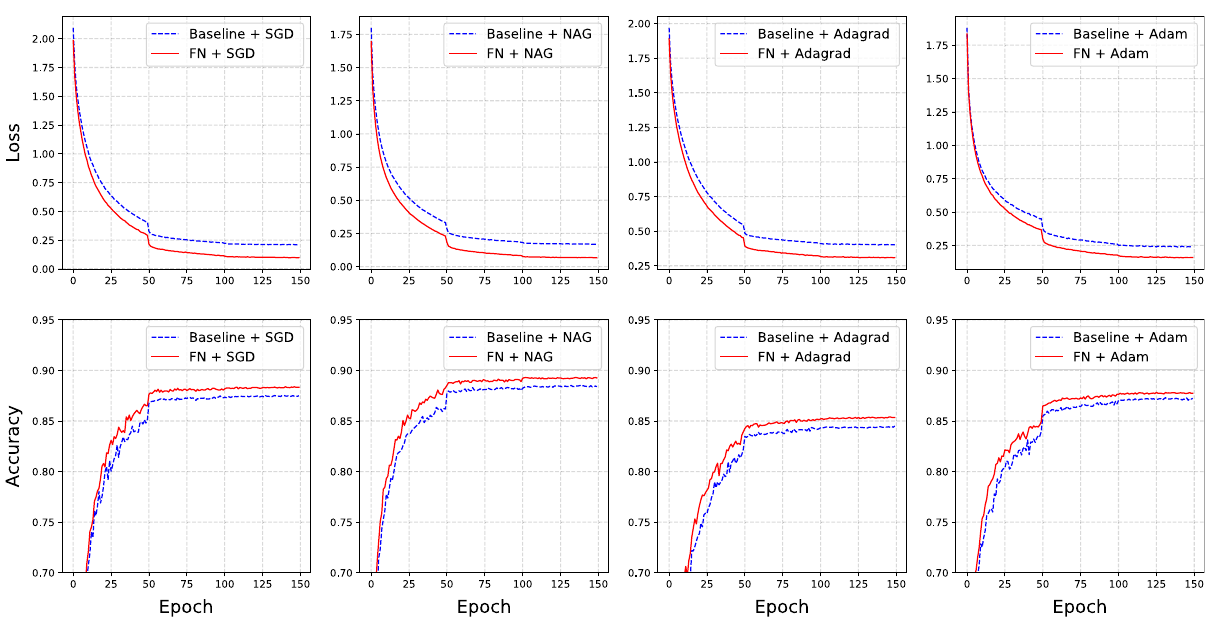
Figure 4. Results of training AlexNet on the CIFAR10 dataset. The top panel shows the training loss of the baseline (blue dashed line) and FN models (red solid line) with four different optimizers. The bottom panel shows the testing accuracy of the baseline (blue dashed line) and FN models (red solid line) with different optimizers. The curves represent the median training loss and testing accuracy of the ten repeated